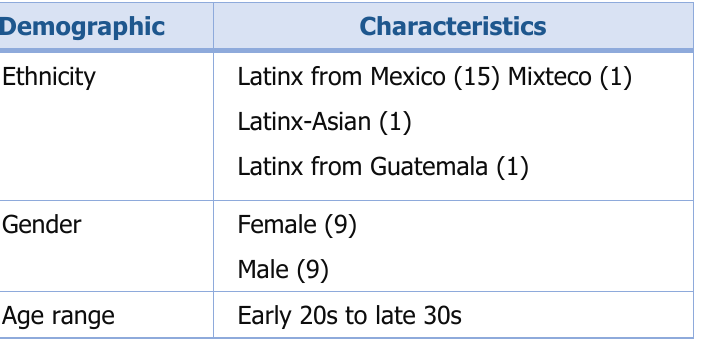
Table 1. Staff Interviewee